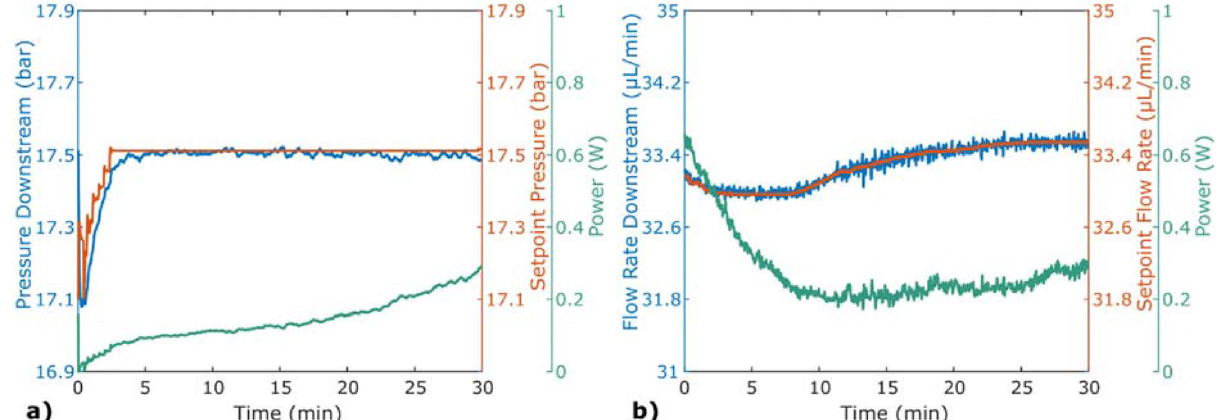
Figure 7. Pressure and flow stabilisation for a regulated setpoint. An ISCO pump was used in manual mode to demonstrate stabilisation for pumps that cannot be computer controlled. ( a ) Pressure stabilisation was performed with a pump set flow of 100 μL/min resulting in a downstream pressure around 17.5 bar. ( b ) Flow rate stabilisation was performed with a pump set flow at 40 μL/min, resulting in a flow rate around 33.5